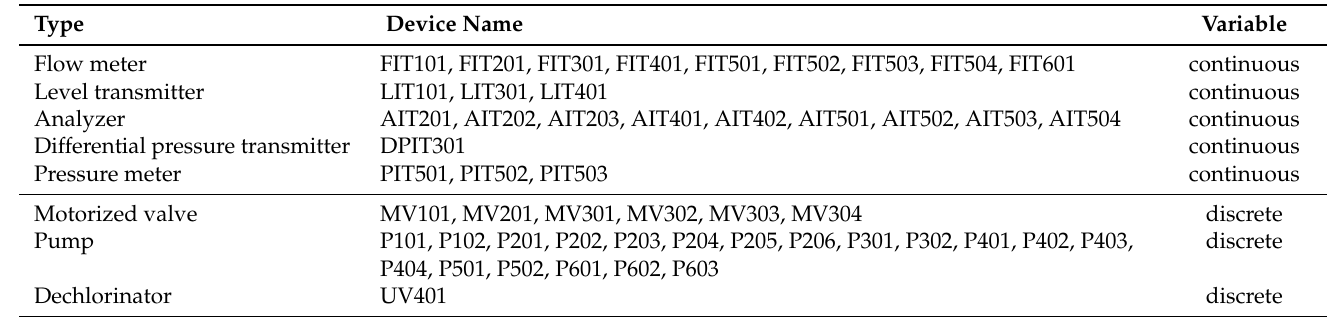
Table 2. Sensors and actuators of the SWaT